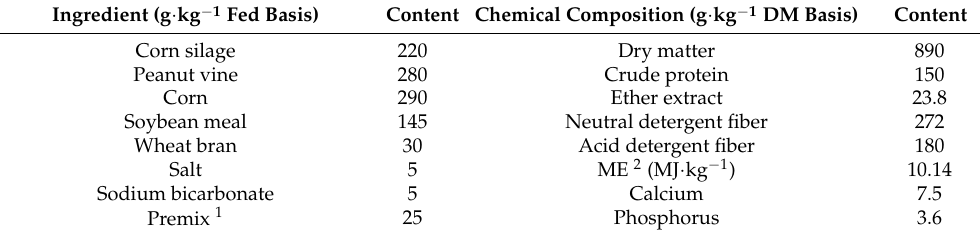
Table 1. Ingredients and chemical composition of the basic